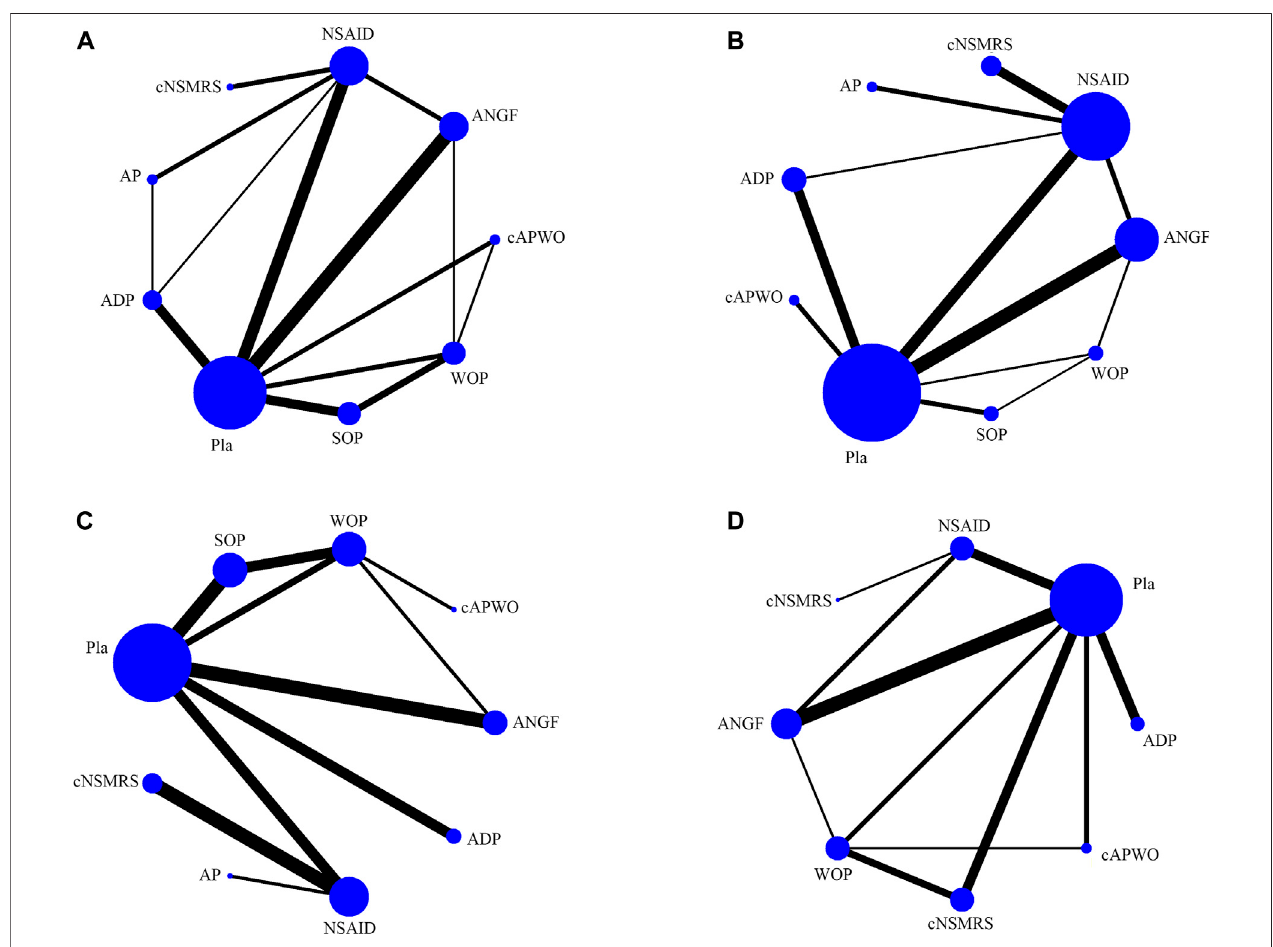
FIGURE 1 | Structure of main network formed by interventions. The lines between treatment nodes indicate the direct comparisons made within randomised controlled trials. The size of the node re fl ects the number of participants in the intervention, the larger the node, the more participants. (A) Pain relief. (B) Function improvement. (C) TEAEs. (D)